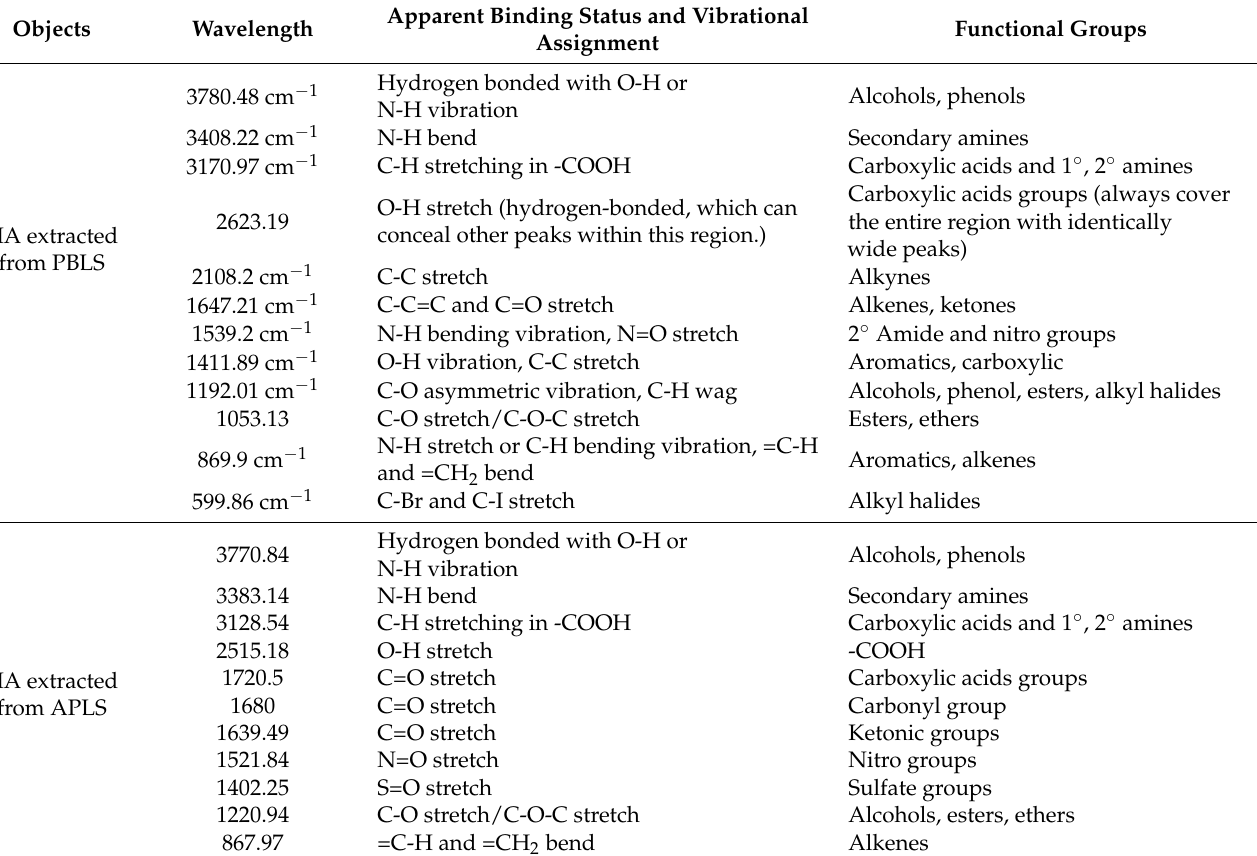
Table 1. Overview of FTIR outcomes for isolated humic